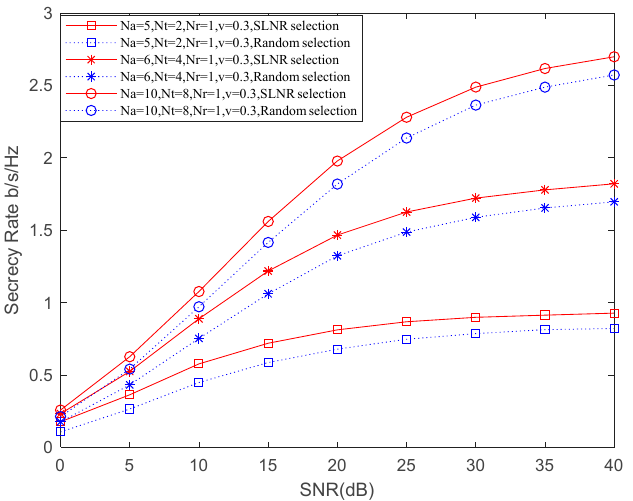
Figure 3. SR over SNR under different schemes for different 𝑁 (cid:3028) and 𝑁 (cid:3047) .